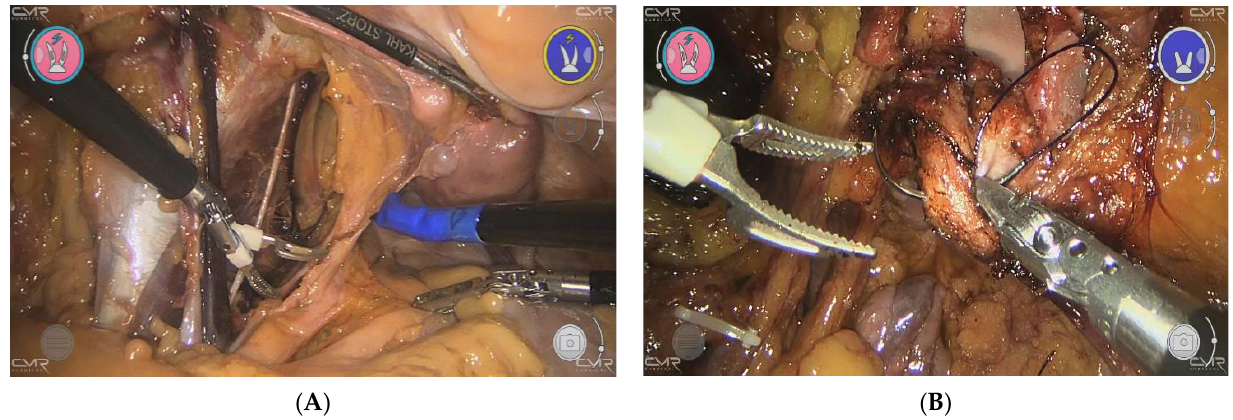
Figure 3. Endoscopic view of the Versius system. ( A ) Posterior exenteration after systematic pelvic lymphadenectomy. ( B ) Suturing of the vaginal cuff using a monofilament suture. Needle holder in the right hand and bipolar clamp in the left hand.